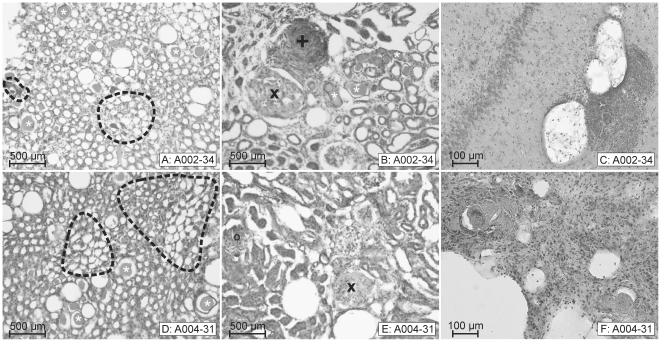
Severe kidney pathology in SHRSP corresponds to final stages of cerebral vascular pathology.
A–C: SHRSP (animal 2, 34 weeks old) with cerebral microbleeds. D–F: SHRSP (animal 4, 31 weeks old) with cerebral infarctions containing small vessel occlusions. There is a strong correlation between an advanced kidney pathology, i.e. peritubular aggregations of erythrocytes, protein cylinders and different stages of glomerulosclerosis with cerebral infarctions accompanied by either microbleeds (here hippocampus, C) or small vessel occlusions with surrounding necrotic tissue (F). A
&
D: kidney medulla, B
&
E: kidney cortex, peritubular aggregations of erythrocytes are marked by black dashed lines (A
&
D), protein cylinders by white asterisks (A, B
&
D). Different stages of glomerulosclerosis are marked in B
& E (o, x; see also 
Figure 5
). In addition kidney vessels are affected by thrombotic microangiopathy (+
 in
B). B corresponds to 
Figure 5

E. A002-34: animal number 2, 34 weeks old.